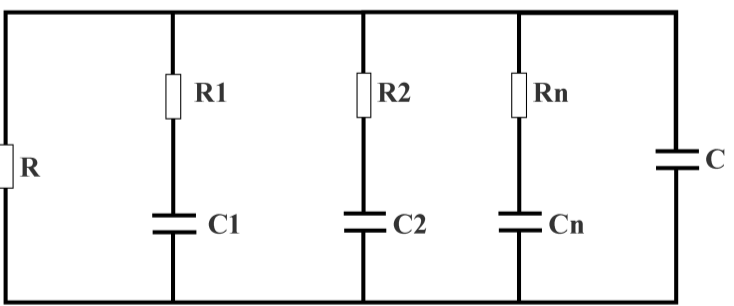
Figure A1. Generic electrical model for a material with n relaxation times. The input voltage stimu- lus is applied at time t 1 and starts a ramp with rate k (V/s) until t 2 . A constant value HV is held for the time interval t 3 − t 2 . A ramp with rate −k (V/s) follows for the time window t 4 − t 3 . At t 4 , the input stimulus ends, and the system returns to its unbiased status.